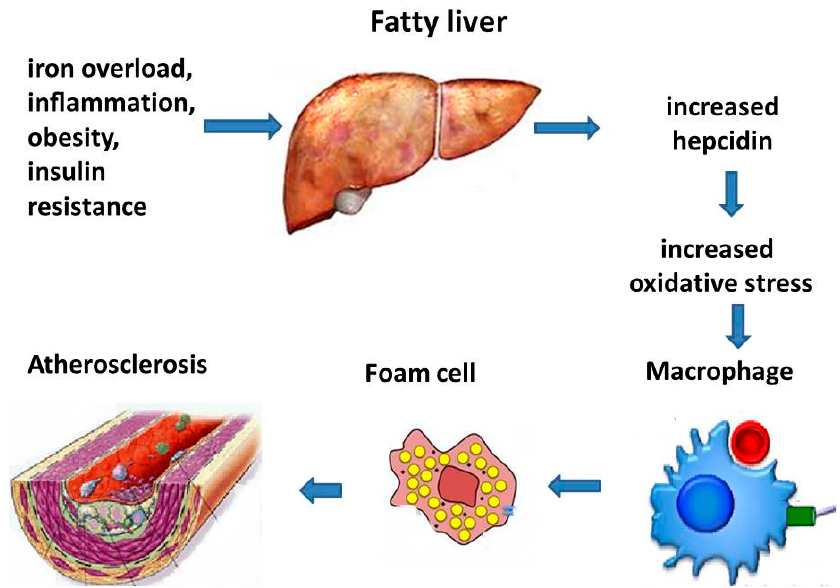
Figure 1. Simplified pathophysiological mechanisms of iron induced vascular damage through fatty liver.